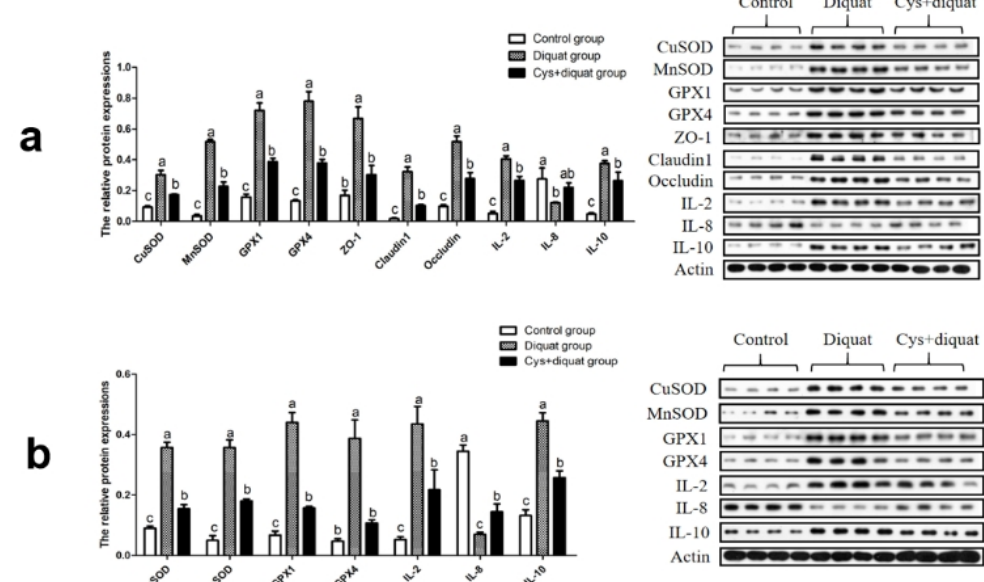
Figure 3. Effects of dietary supplementation of coated cysteamine on the expression of antioxidant-, tight junction- and inflammation-related proteins in pigs ( a ) jejunum and ( b ) colon. CuSOD: Cu-SOD; MnSOD: Mn-SOD; GPX1: glutathione peroxidase 1; GPX4: glutathione peroxidase 4; ZO-1: zonula occludens-1; IL-2: interleukin-2; IL-4: interleukin-4; IL-8: interleukin-8; IL-10: interleukin-10. Results are expressed as means ± SEM (n = 8). Means in the same row with different letters were significantly different ( p < 0.05).